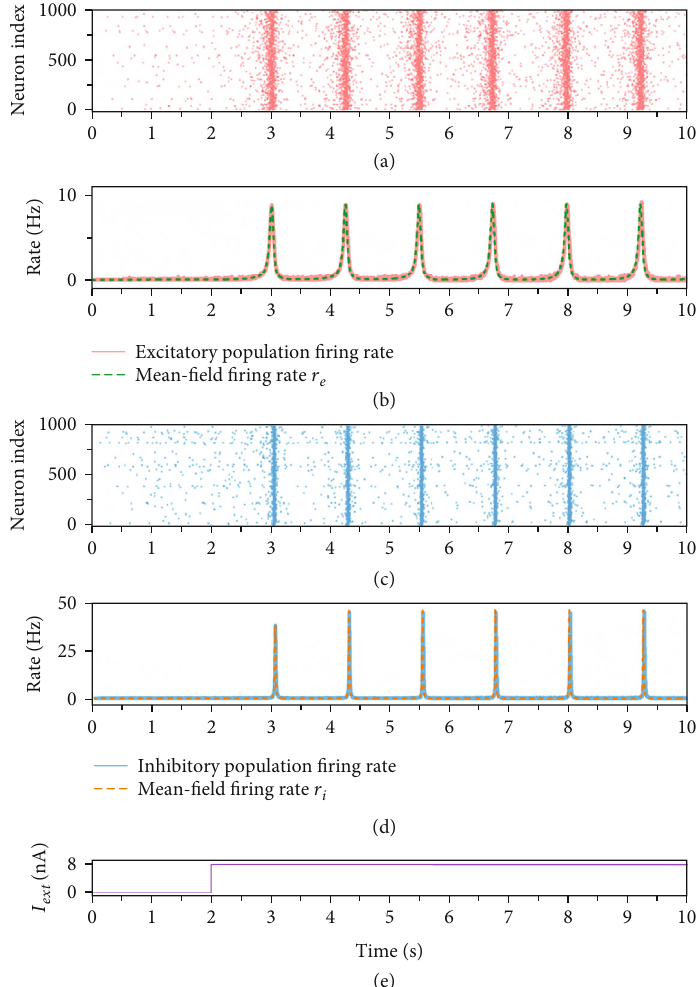
Figure 1: Activities of the network model and the mean- fi eld model. (a) Raster plot of 1000 randomly selected neurons in the excitatory population. (b) The fi ring rate of the excitatory population (red solid) and the mean- fi eld fi ring rate r (green dashed). (c) Raster plot of e 1000 randomly selected neurons in the inhibitory population. (b) The fi ring rate of the inhibitory population (blue solid) and the mean- fi eld fi ring rate r (orange dashed). (e) At t = 0 , a current I = 0 is applied to all excitatory neurons, and set to I = 8 at t = 2 ext ext i